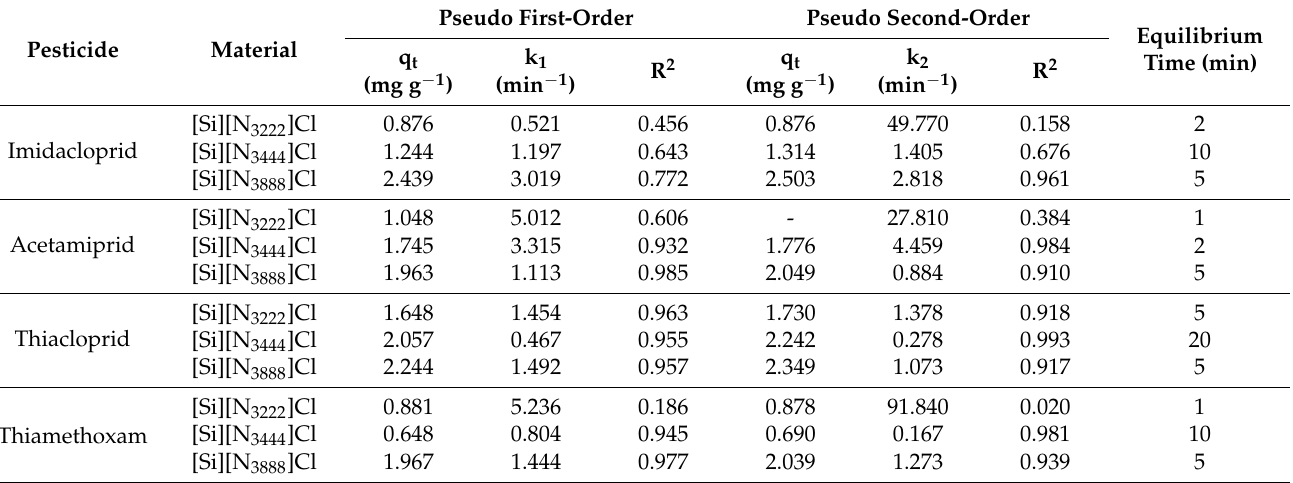
Table 3. Adsorption parameters obtained from the fitting of adsorption kinetic experimental data with the Pseudo First-Order and Pseudo Second-Order models, and the respective correlation coefficients for imidacloprid, acetamiprid, thiacloprid, and thiamethoxam with [Si][N 3222 ]Cl, [Si][N 3444 ]Cl, and [Si][N 3888 ]Cl. Pseudo First-Order Pseudo Second-Order Material